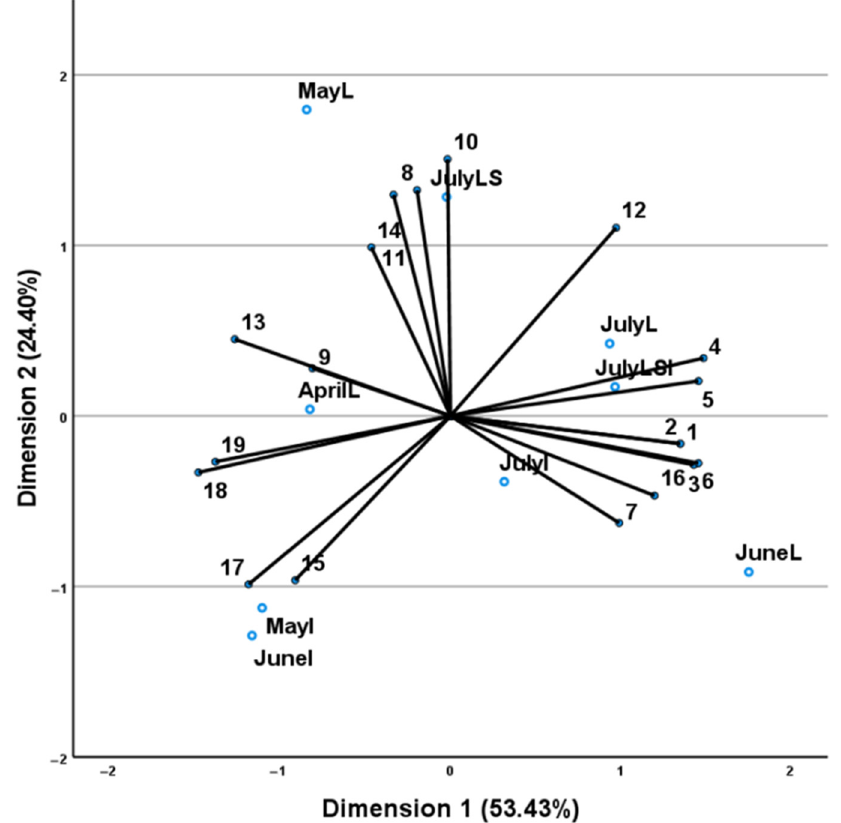
Figure 5. CATPCA analysis of S. officinalis samples (L: leaves, I: inflorescences, LS: leaves and stems, LSI: leaves, stems and inflorescences, following the name of the collection month), based on their essential oil compounds (numbers of which correspond to those of Table 4). Axes 1 and 2 accounted for 77.83% of the total variability and the total value of Cronbach’s alpha (alpha = 0.984) indicated a high level of internal consistency.